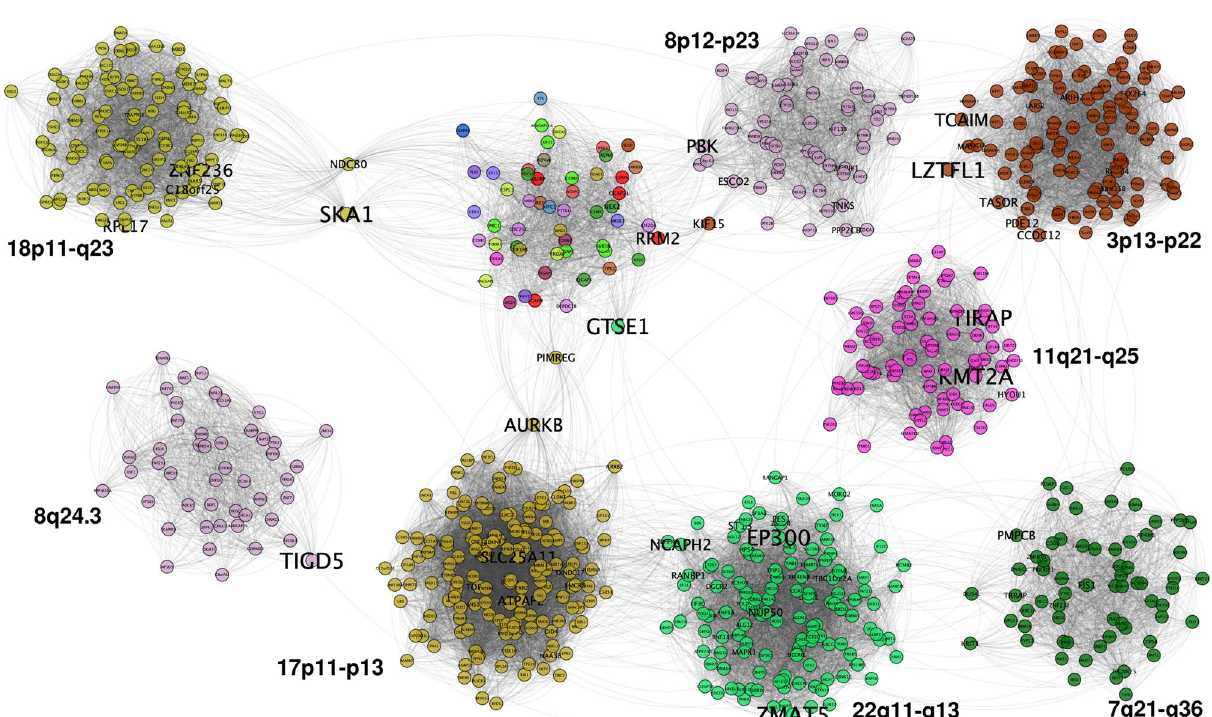
Figure 4. Luminal A 30-core network. In this case, a giant component is divided into nine clearly separated modules. The size of gene names is proportional to the betweenness centrality of genes. Aside of each module, the chromosome region in which those genes are located is depicted. To notice that genes with highest betweenness centrality are those that join communities, such as the case of SKA1, AURKB, TIGD5, or